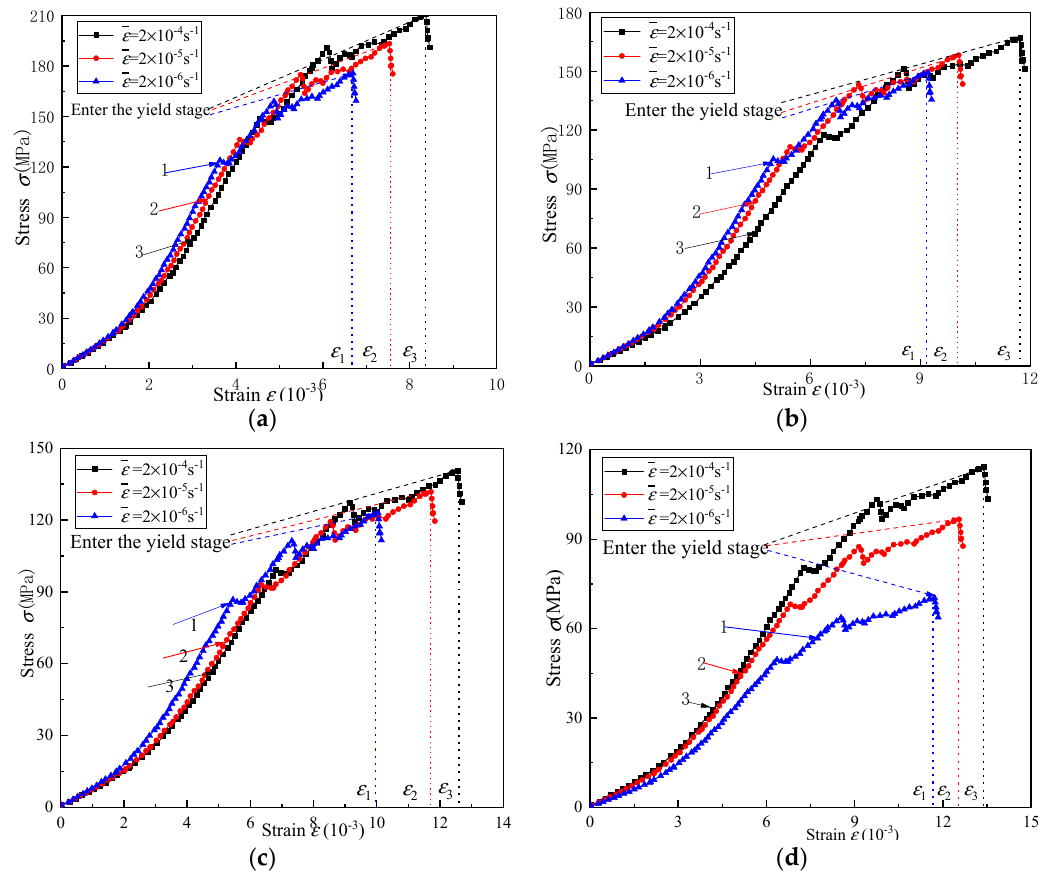
Figure 6. Plot of axial stress versus axial strain for uniaxial compression test with 𝜀̅ = 2 × 10 − 4 s − 1 , 2 × 10 − 5 s − 1 , 2 × 10 − 6 s − 1 . ( a ) D = 0.043; ( b ) D = 0.357; ( c ) D = 0.625; ( d ) D = 0.754.